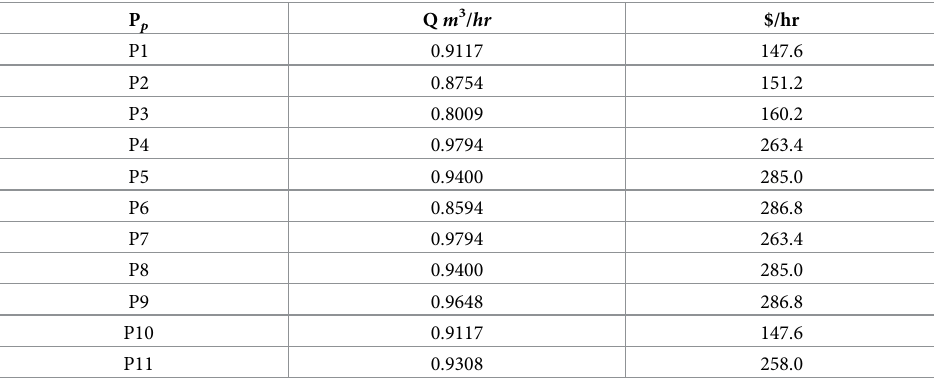
Table 8. Gas consumption levels for each technology obtained from Eq 10.